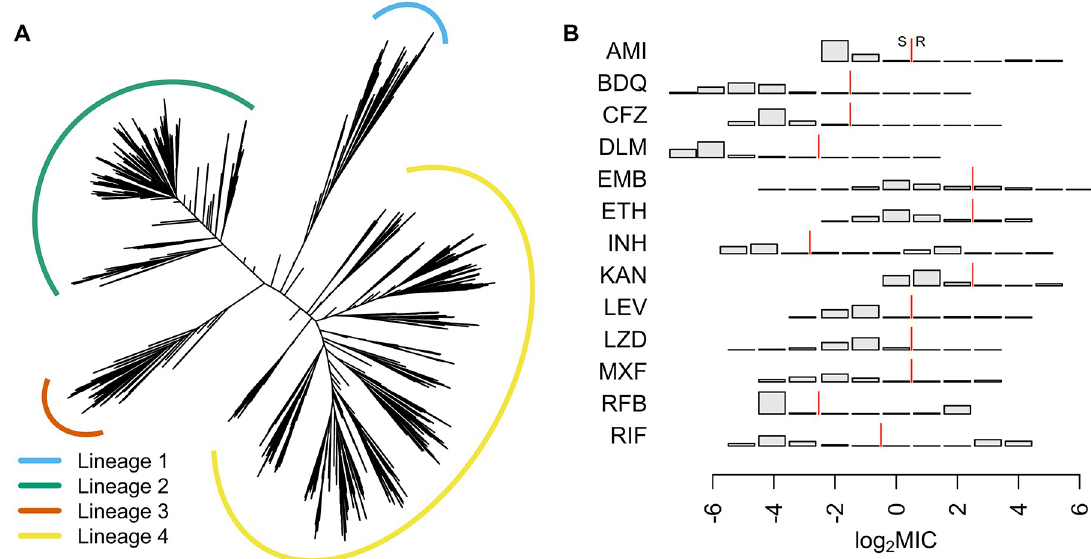
Fig 1. ( A ) Phylogeny of 10,228 isolates sampled globally by CRyPTIC used in the GWAS analyses. Lineages are coloured blue (lineage 1), green (2), orange (3), and yellow (4). Branch lengths have been square root transformed to visualise the detail at the tips. ( B ) Distributions of the log 2 MIC measurements for all 13 drugs in the GWAS analyses, AMI, BDQ, CFZ, DLM, EMB, ETH, INH, KAN, LEV, LZD, MXF, RFB, and RIF. The red line indicates the ECOFF breakpoint for binary resistance versus sensitivity calls [31]. AMI, amikacin; BDQ, bedaquiline; CFZ, clofazimine; DLM, delamanid; ECOFF, epidemiological cutoff; EMB, ethambutol; ETH, ethionamide; INH, isoniazid; KAN, kanamycin; LEV, levofloxacin; LZD, linezolid; MIC, minimum inhibitory concentration;